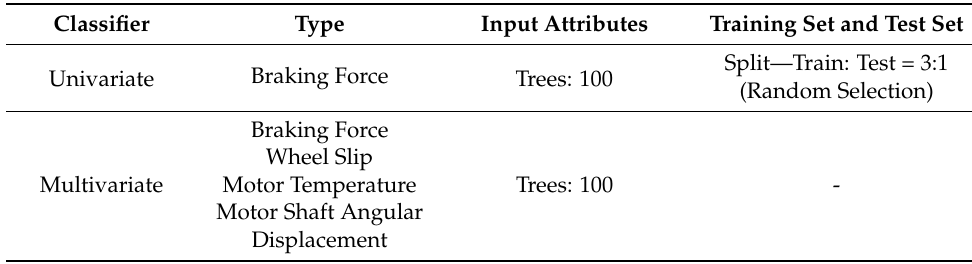
Table 5. TSF Model Parameters.